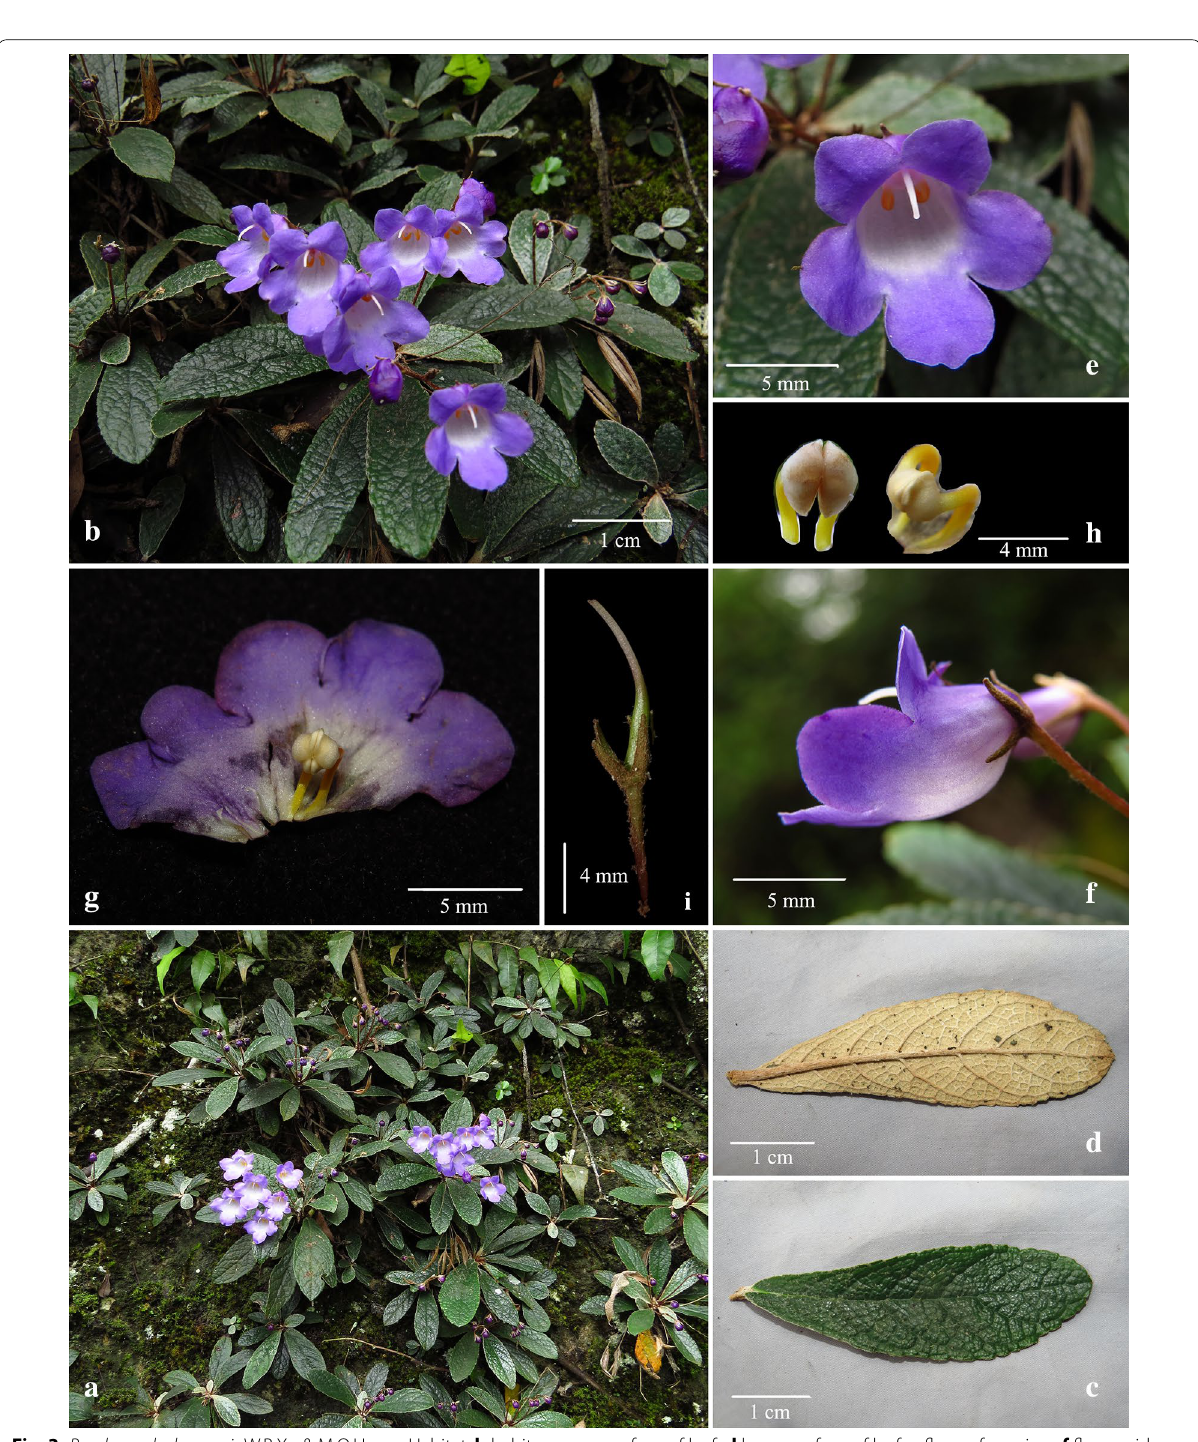
Fig. 3 Paraboea dushanensis W.B.Xu & M.Q.Han. a Habitat; b habit; c upper surface of leaf; d lower surface of leaf; e flower face view; f flower side view; g opened corolla showing stamens and staminodes; h stamens; i pistil and